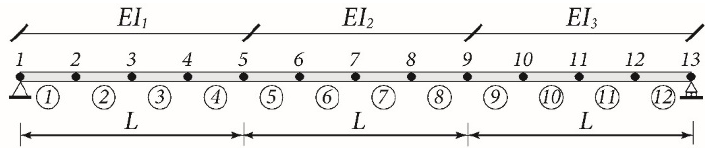
Figure 3. FEM for a simply supported bridge.